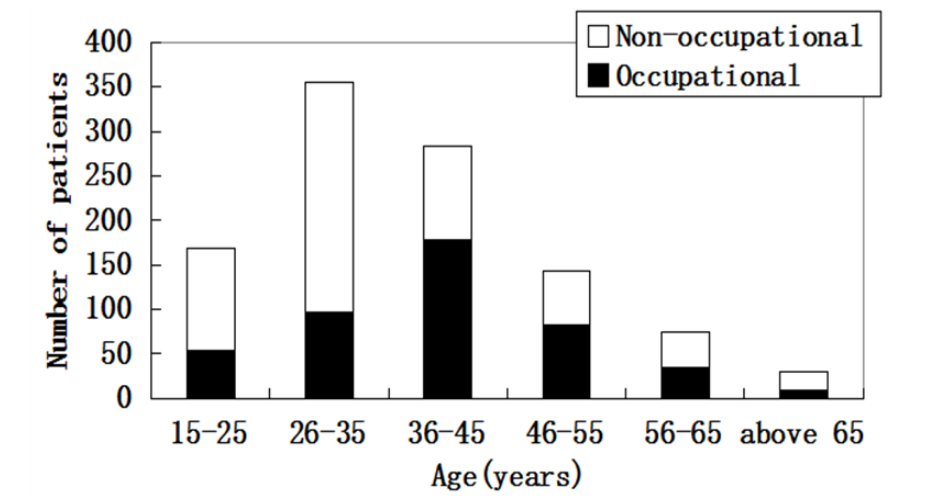
Figure 1. Age distribution of occupational and non-occupational eye trauma.